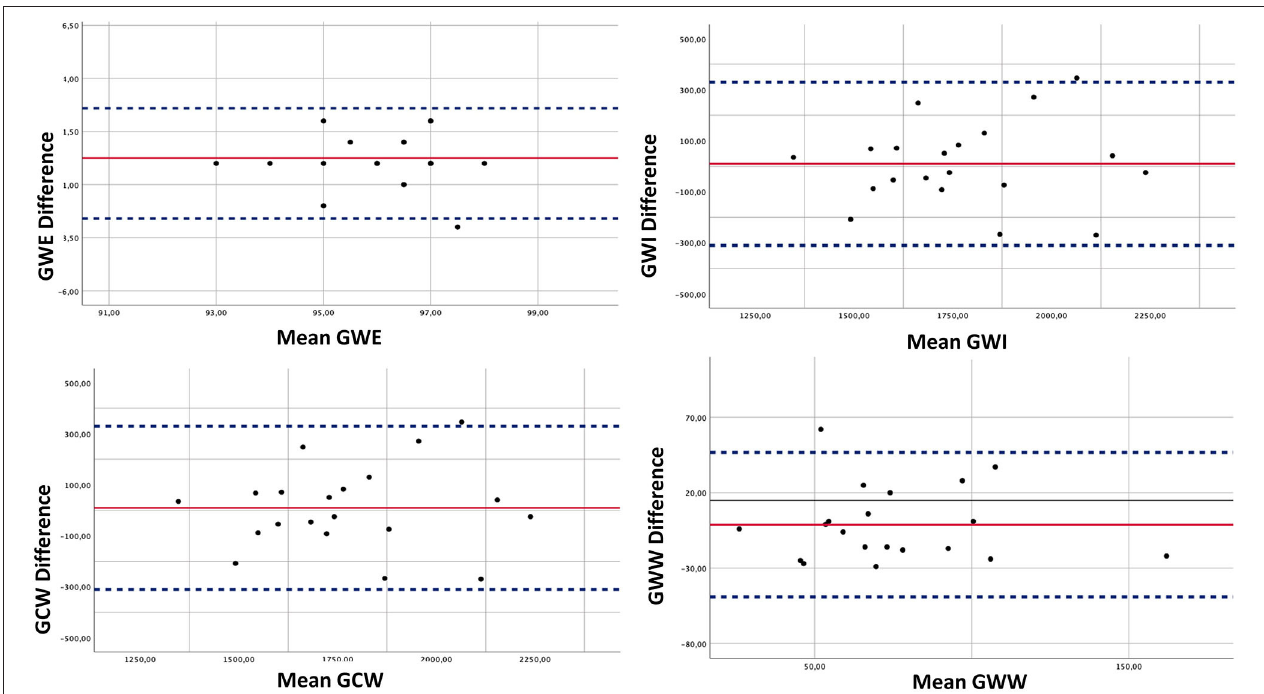
FIGURE 2 | Inter-observer reproducibility. The Bland Altman analysis was performed to assess in a sample of patients the inter-observer variability of the main indices of non-invasive myocardial work. Continuous line represents mean values for each parameter, and dotted lines represent bias and 95% limits of